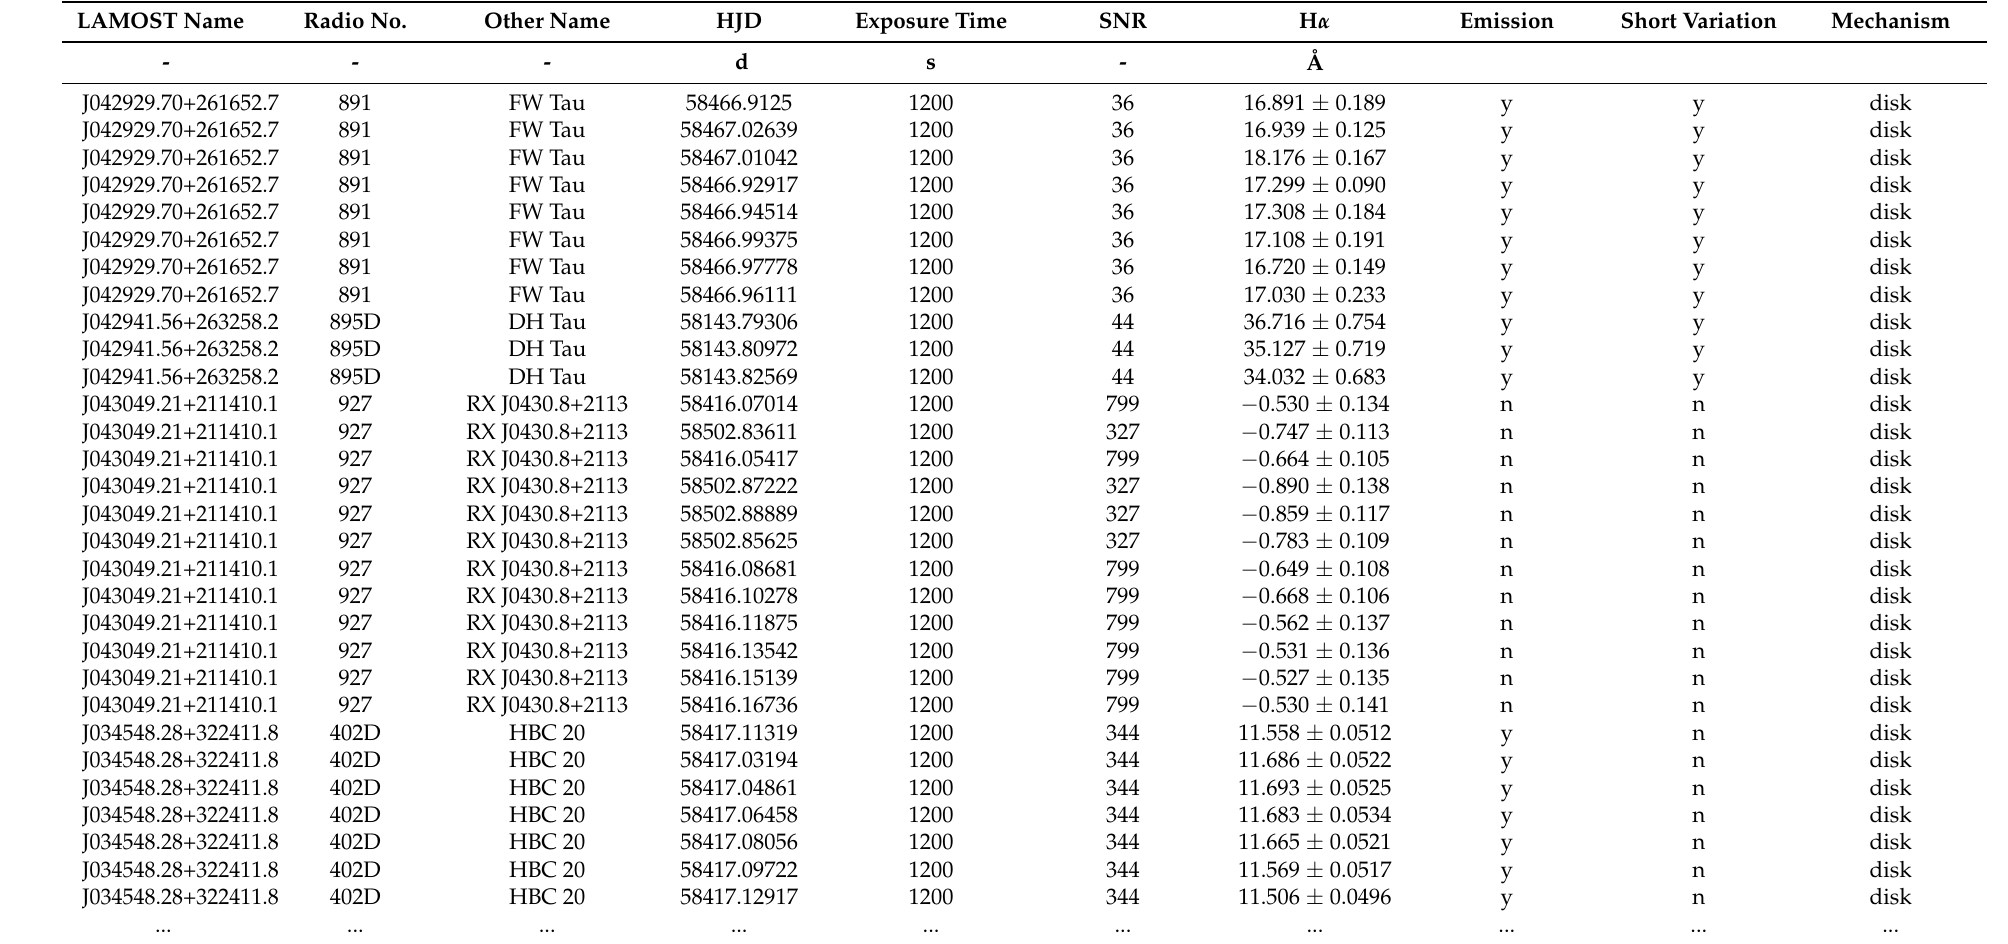
Table 3. Radio stars with LAMOST medium-resolution spectra and their H α variations in short time scale (about 20